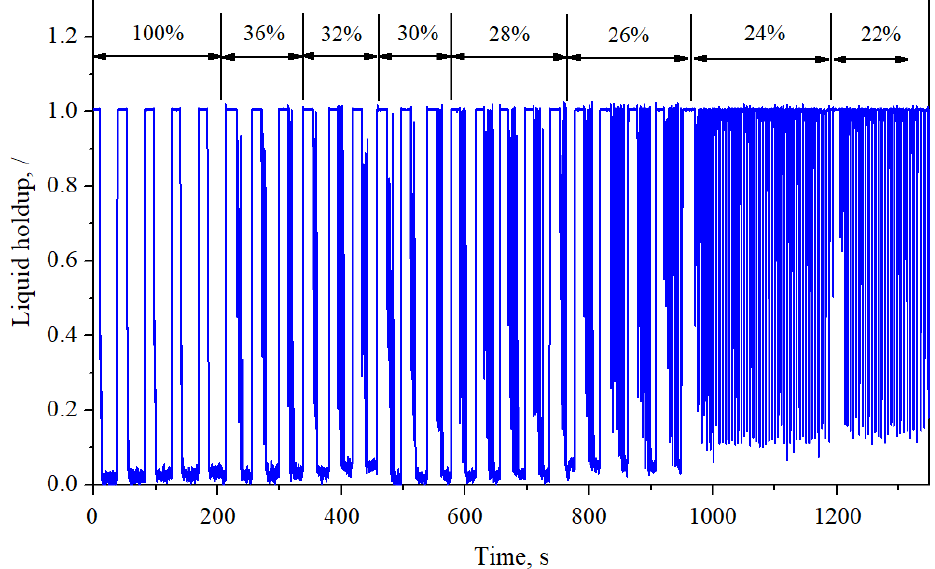
Figure 11. Experimental time traces of liquid holdup at the riser top ( U GS = 0.11 m/s and U LS = 0.15 m/s).